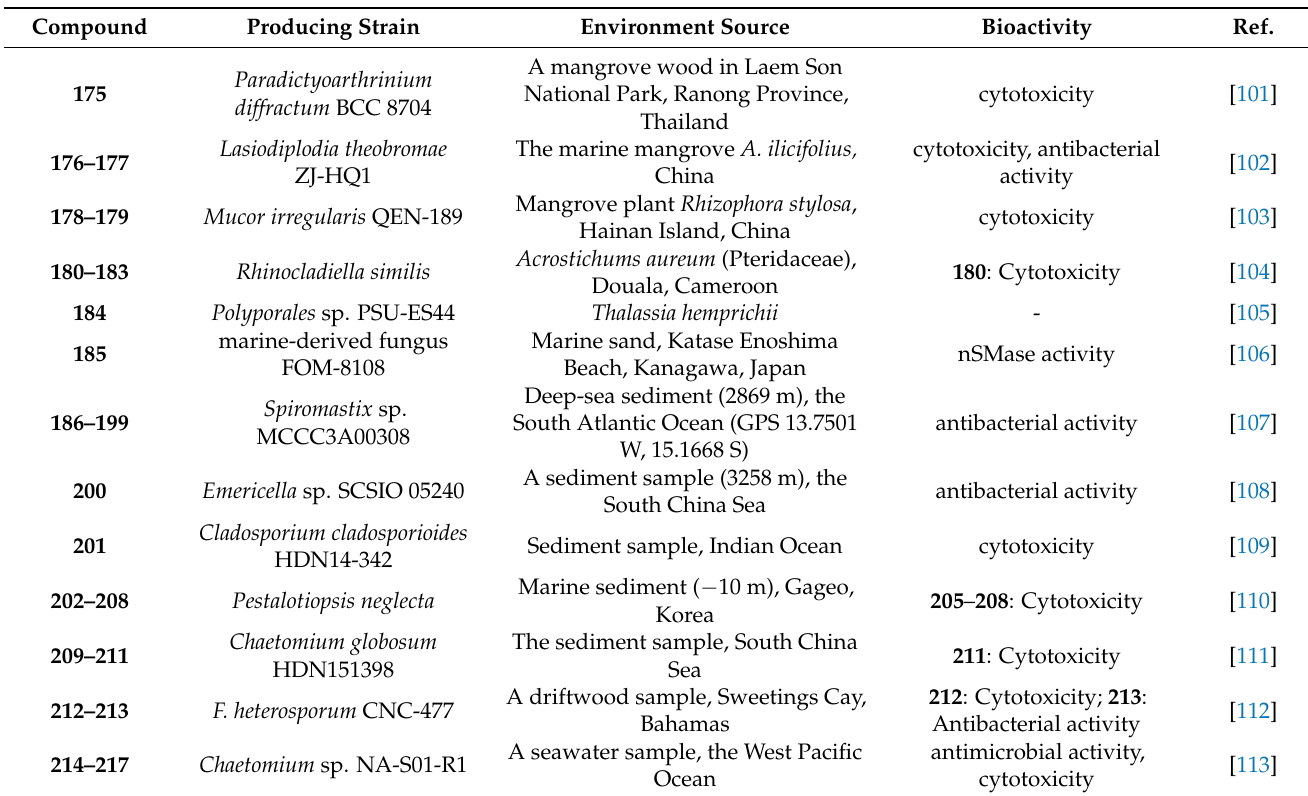
Figure 8. Percentages of new halogenated compounds published in different journals (1994–2019). Fungi isolated from sponges, sediments, algae, and mangroves produced most of the new halogenated compounds (22.6, 27.6, 11.1, and 10.6%, respectively) (Figure 9). Marine animals hosted diverse fungal species and strains that produced more than 50% of the new halogenated compounds from 1994 to 2019, indicating that they are an excel- lent source for the discovery of new halogenated compounds.